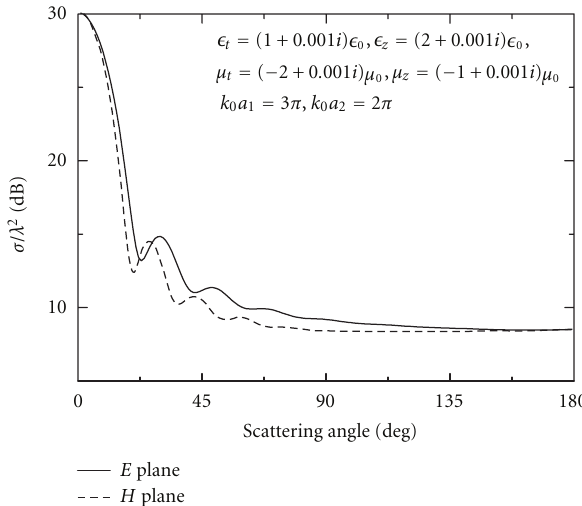
Figure 4: Radar cross sections (RCSs) versus scattering angle θ (in degrees) in the E -plane (solid curve) and in the H -plane (short- dashed